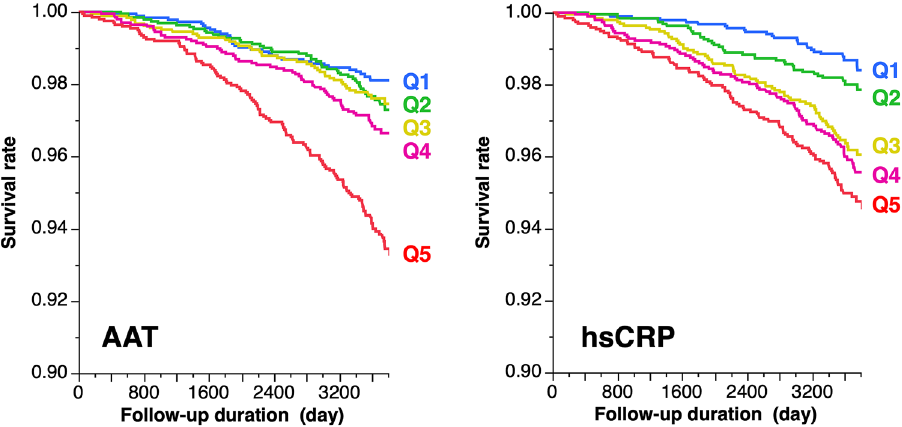
Figure 2. Survival curve of all-cause mortality by the quintiles of baseline α1-antitrypsin (AAT) and high- sensitivity C-reactive protein (hsCRP)